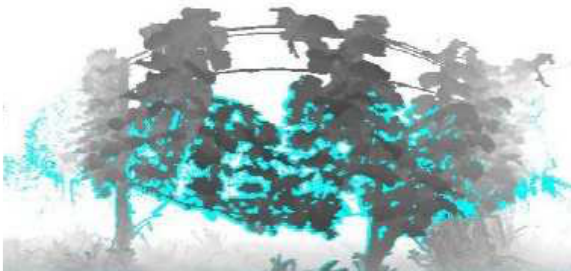
Figure 4: Range image with highlighted areas arising from multiple echoes at